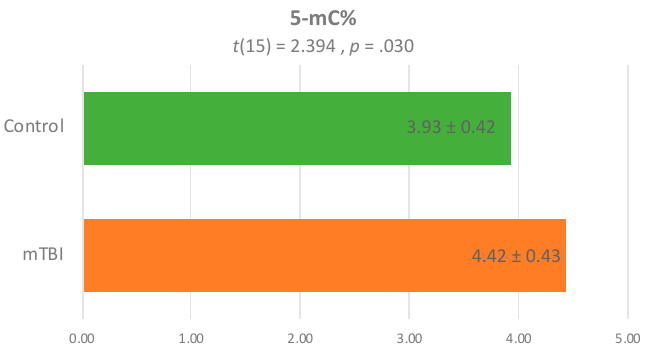
Figure 1. Comparison of peripheral blood global methylation ratio (5-mC%) between mTBI and healthy control college student participants. Note: Biological samples that failed to pass the quality of global DNA methylation ratio (5 mC%) assay were not included in the analysis.